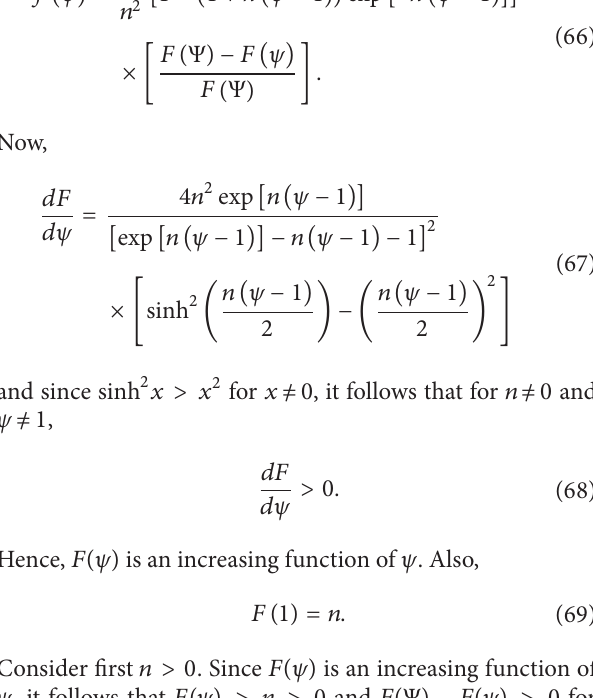
Figure 1: The function 𝑓(𝜓) defined by (62) plotted against 𝜓 for 𝑛 = −0.1, 0.5, 1 , and 2 for Ψ = 5 .